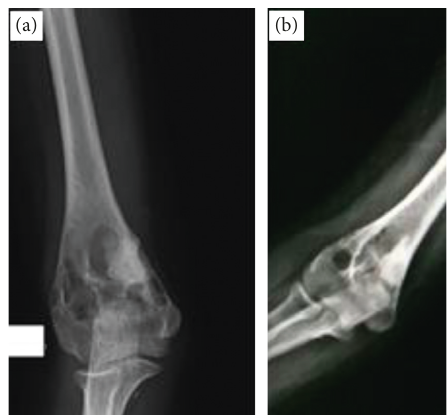
Figure 7: (a) AP X-ray of the distal humerus solid variant ABC about 4 years after surgery showing signs of recurrence. (b) X-ray repeated one year later with no further intervention showing al- most complete healing and remodeling of the